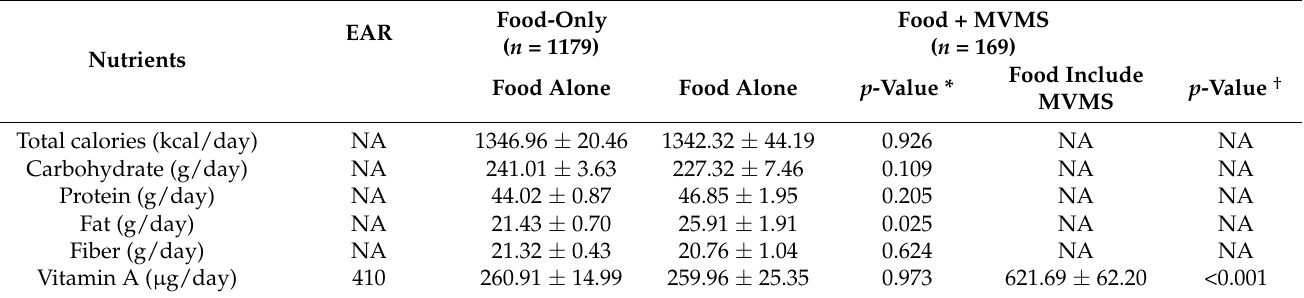
Table 3. Daily nutrient intake from food alone and included MVMS in